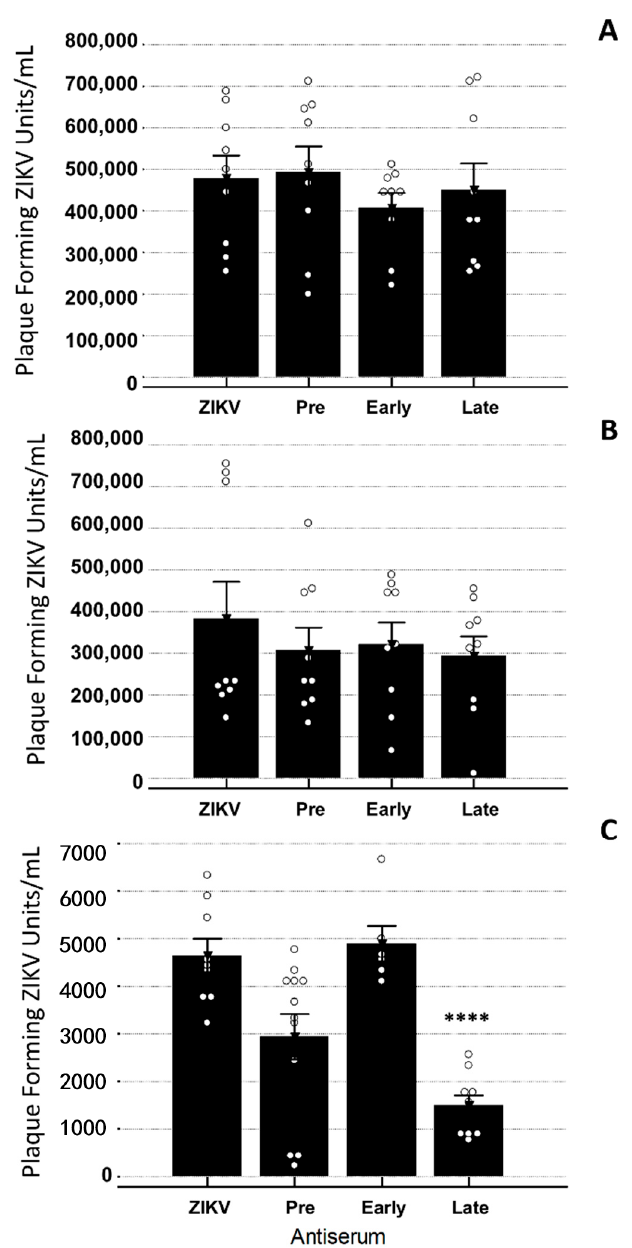
Figure 6. Viral titration of ZIKV in BeWo, HUVECs, and EBs from transwell co-culture 72 h p.i. Bars signify average plaque-forming units per mL ± standard error of 3 independent trials with 3 replicates each. Dots represent individual data points for the treatment. ANOVA with a Tukey–Kramer post-hoc test for pairwise comparisons and a Shapiro–Wilk test for normality of distribution were performed. ( A ) There were no significant changes in ZIKV titer in BeWos from the transwell co-culture when YFV antisera were present. ( B ) HUVEC cells from the transwell co-culture exhibited no significant difference in ZIKV titer when YFV antisera were present. ( C ) Significant decreases in ZIKV titers were seen in EBs taken from the transwell co-culture when Late YFV antiserum was present, when compared to ZIKV only ( p < 0.001). Statistical significance is denoted by ****. All ° are individual data points within that group.